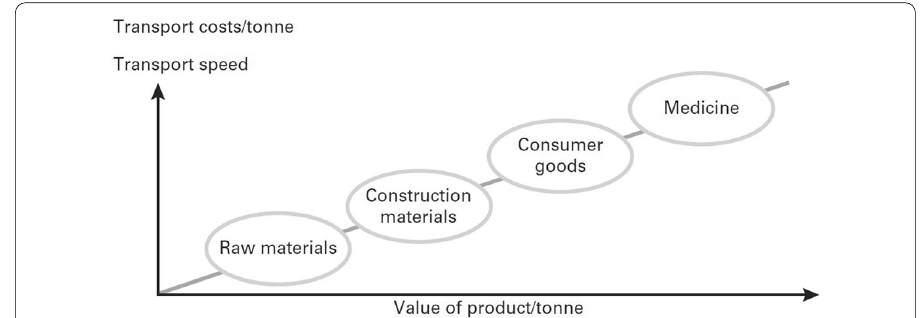
Fig. 1 The relationship between product value and transport speed and costs. Source : Tapaninen